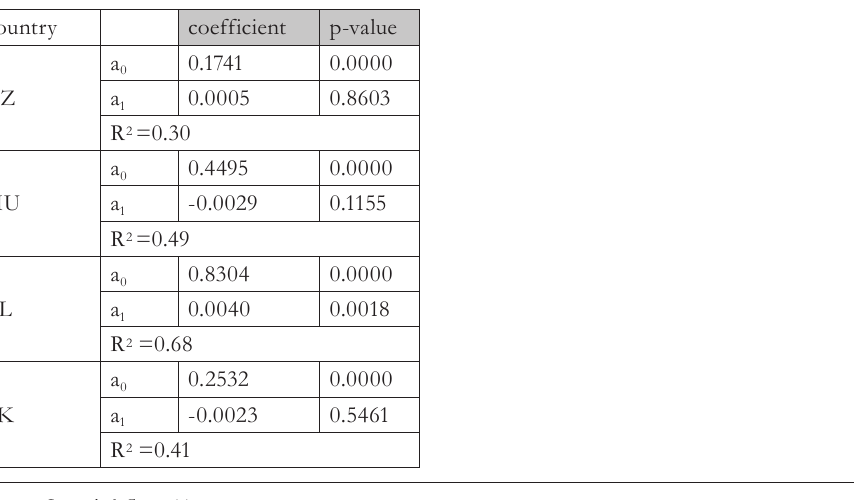
Tab. 4 – OLS estimation of sigma-convergence equation for each Visegrad Group country Source: Author’s own